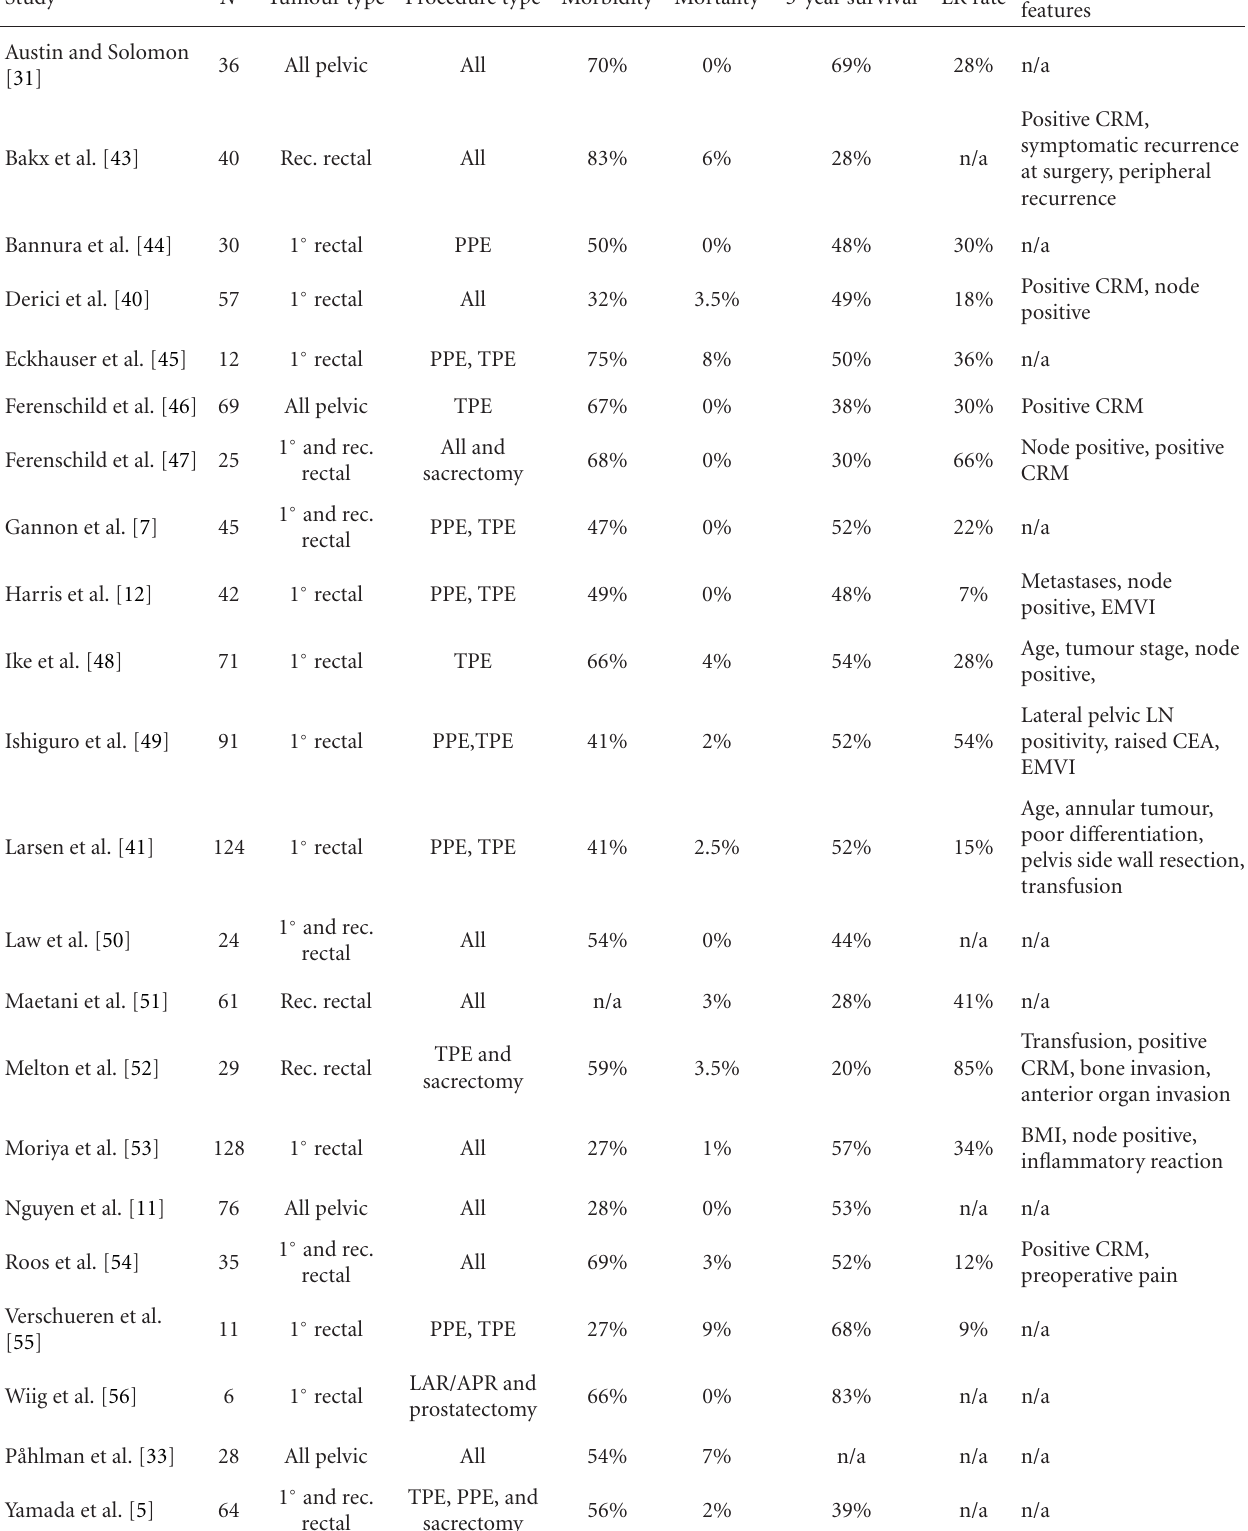
Table 2: Outcomes in pelvic exenteration